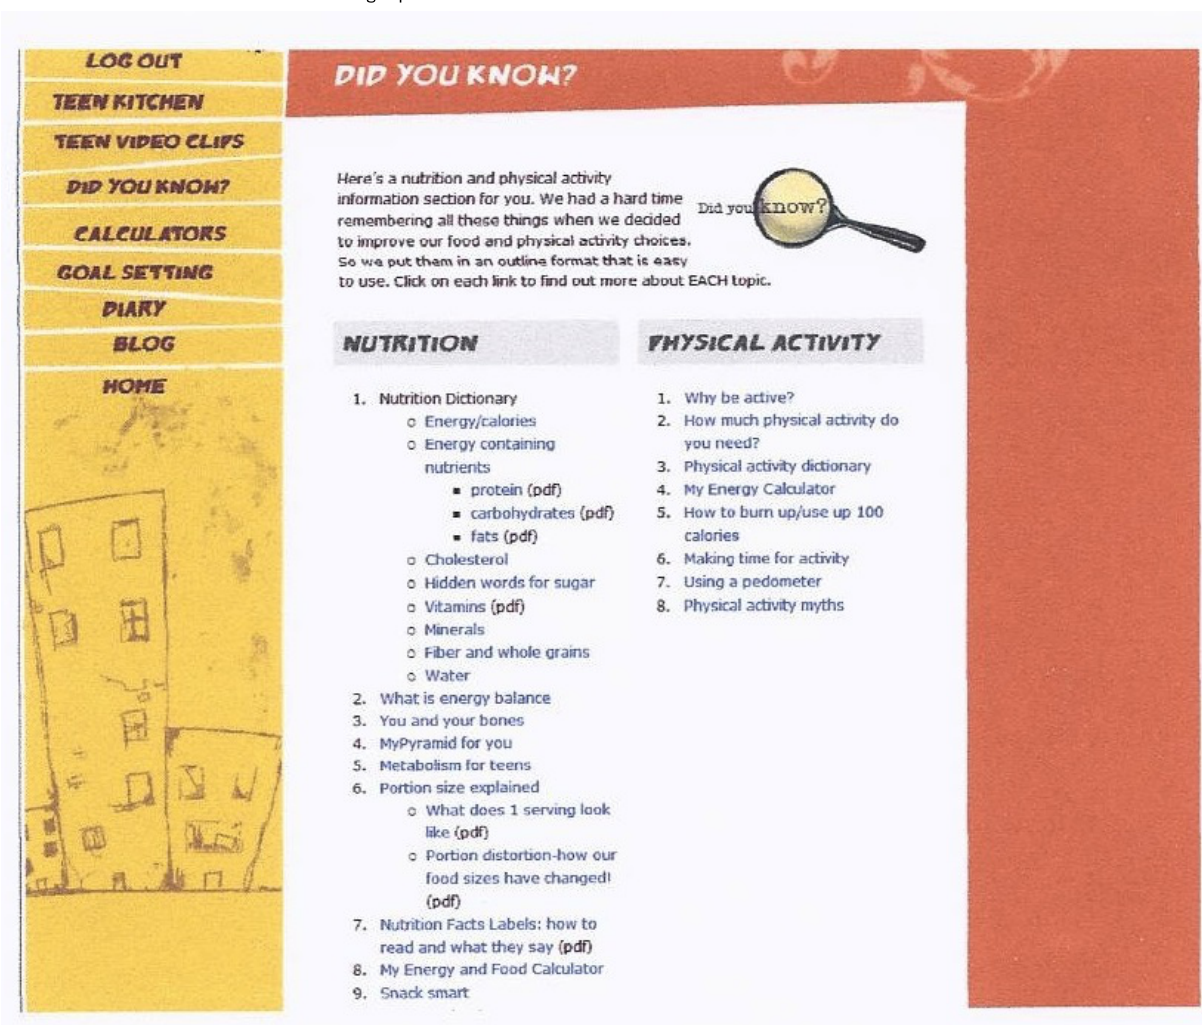
Figure 4. “Did You Know” screenshot showing